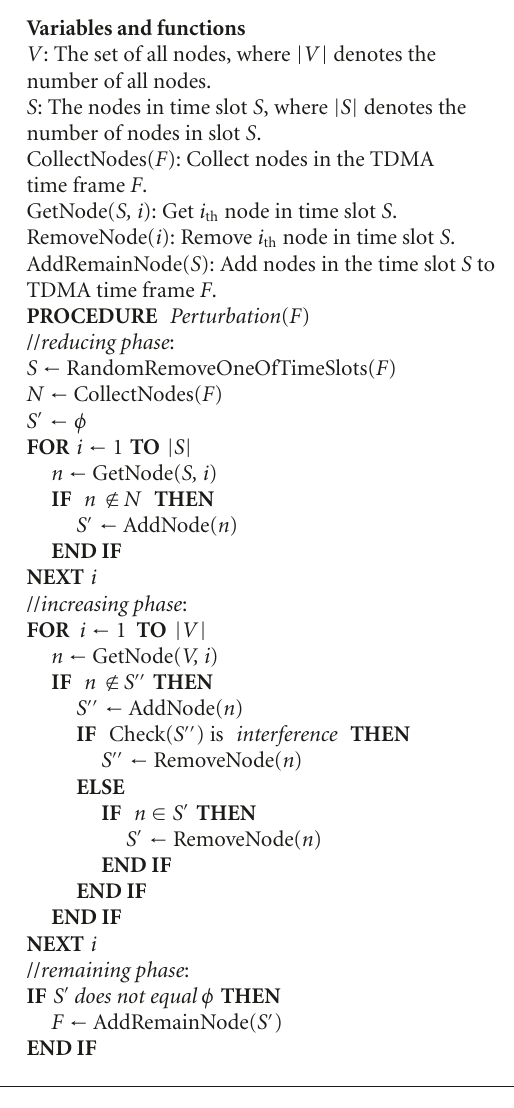
Algorithm 3: Pseudocode of our perturbation